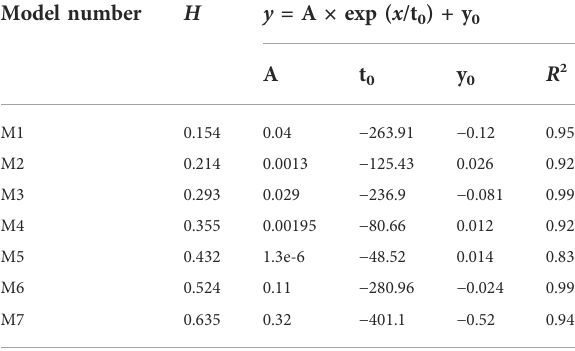
TABLE 6 Damage fi tting equation coef fi cients for different H values. Model